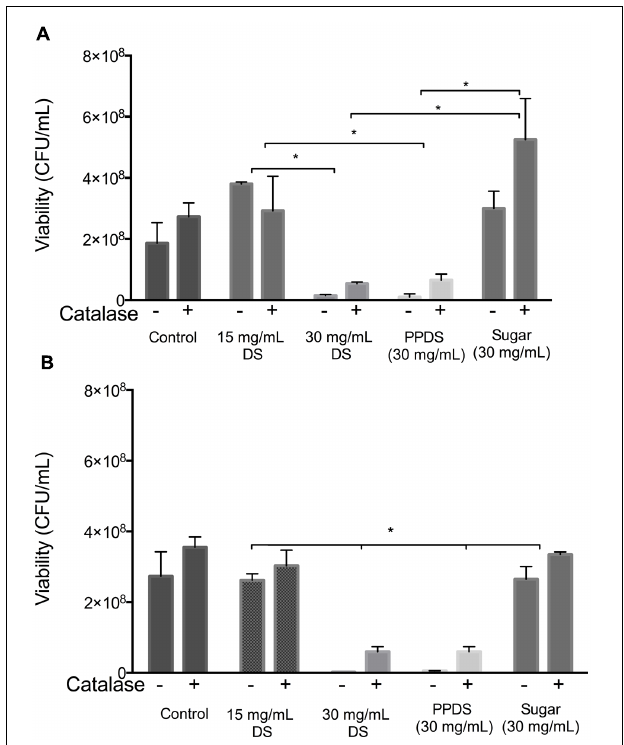
FIGURE 2 | Inhibitory effects of catalase on the antibacterial action of DS. DS treatments; DS, extracted DS polyphenols (PPDS) and artificial DS sugar (Sugar) were added to (A) Escherichia coli and (B) Staphylococcus aureus cell suspensions with or without 100 U/mL catalase. After being incubated at 37 ◦ C for 4 h with shaking, cell viability was determined using surface drop count methods and expressed as viability in colony forming units (CFU). Data is mean ± SD of three independent experiments. Significant differences between treatment groups are indicated as ∗ p <